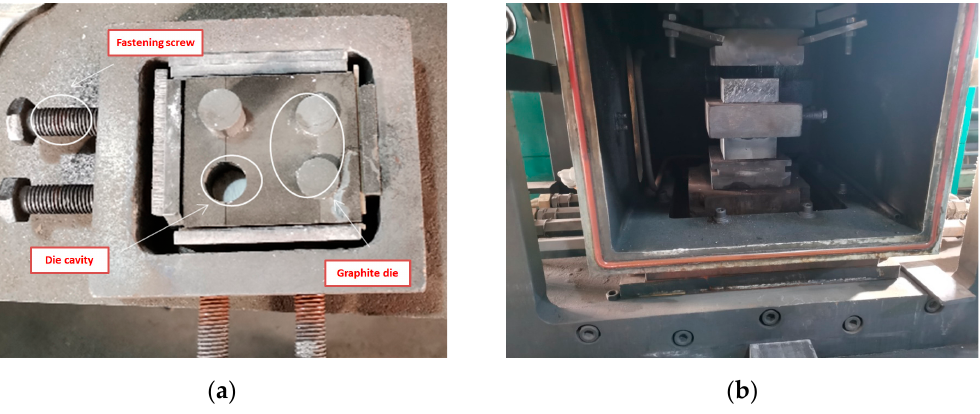
Figure 3. Graphite die and installation: ( a ) Graphite die; ( b ) Die Installation.